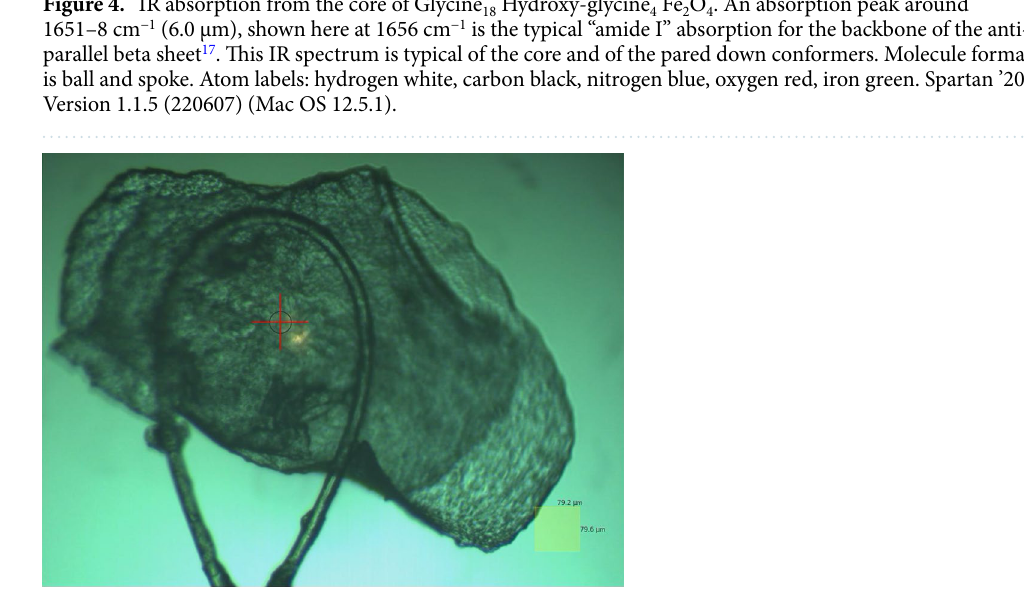
Figure 5. Sutter’s Mill crystal SM2 mounted in preparation for absorbance and diffraction measurements. Scale box at lower right 79.2 µm × 79.6 µm. Image taken by Diamond Light Source Beam line I24 by the beam line staff for JEMMc proposal